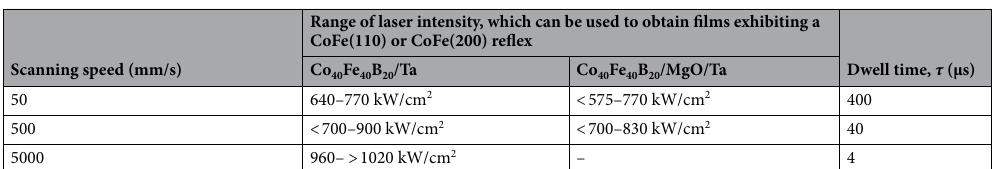
Table 1. Range of laser intensity values inducing Co–Fe crystallization as proven by XRD θ -2 θ scans of